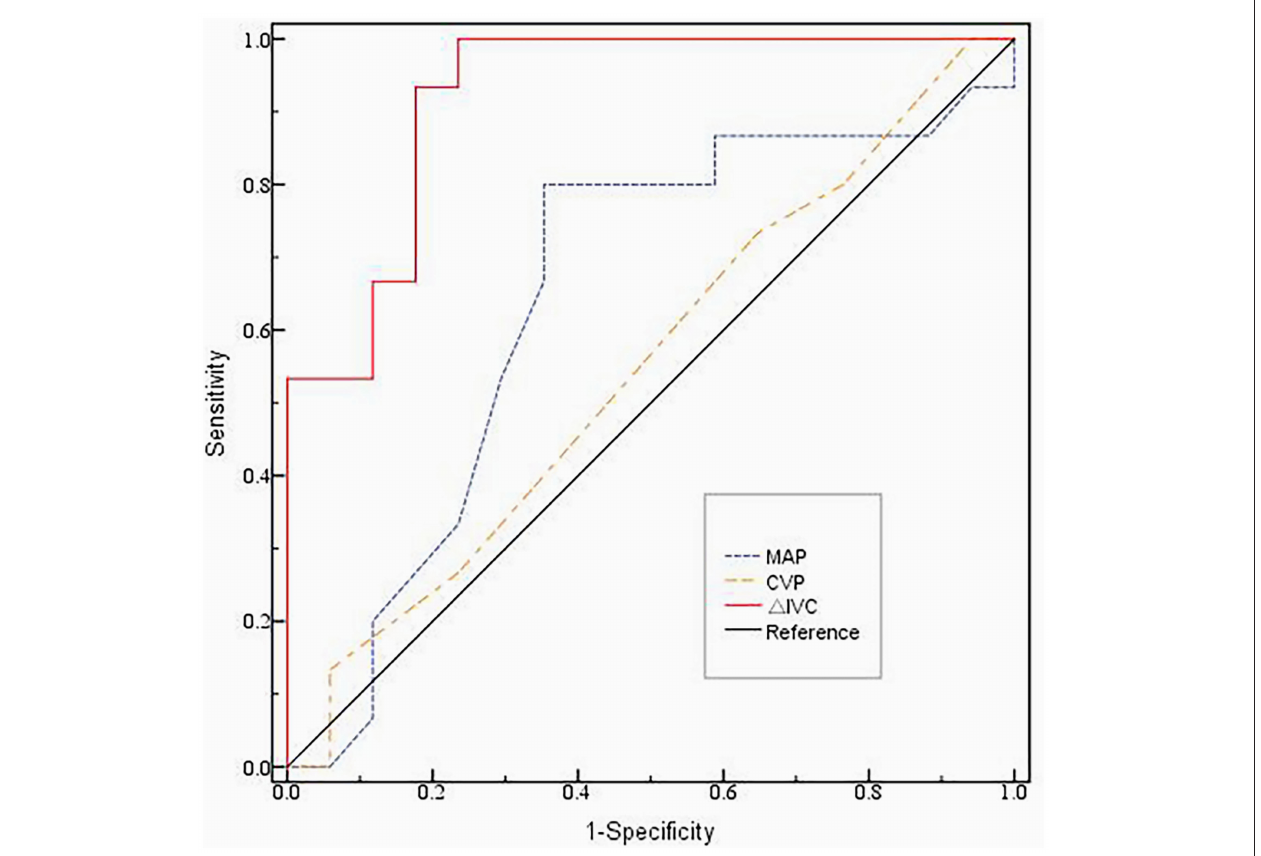
FIGURE 2 | The ROC curve of the 1 IVC, MAP and CVP before volume expansion.The area under the ROC (AUROC) of 1 IVC was 0.922 (95% CI: 0.829–1.000, p < 0.01). The AUROC of MAP was 0.645 (95% CI: 0.444–0.847, p = 0.162). CVP had an AUROC of 0.549 (95% CI: 0.347–0.751, p = 0.637). The cutoff value of 1 IVC used to predict fluid responsiveness was 28.5%, with a sensitivity and specificity of 95.4% and 68.5%, respectively. ROC, Receiver Operating Characteristic; MAP, mean blood pressure; CVP, central venous pressure; 1 IVC, the inferior vena cava